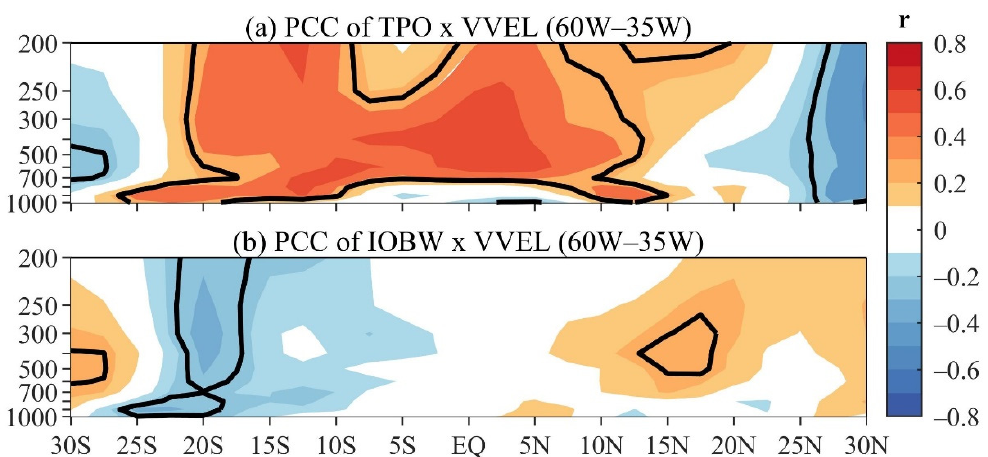
Figure 5. Latitude vertical cross ‐ sections of the partial correlations for the vertical velocity in pressure coordinate averaged in the 60° W ‒ 35° W band (VVEL) during southern summer: ( a ) TPO and VVEL; ( b ) IOBW and VVEL. Graphical display is the same as that in Figure 4.